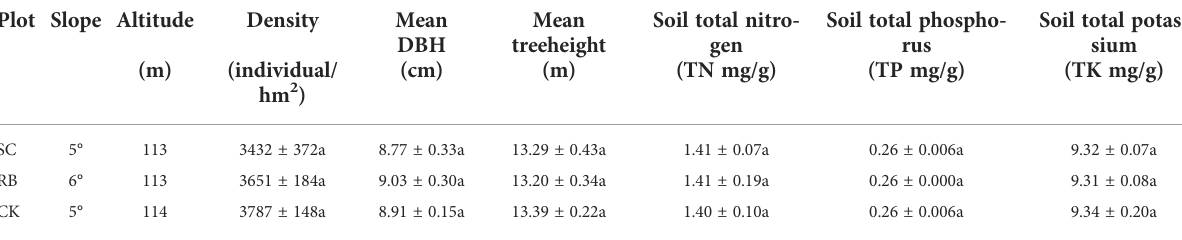
Values represent the mean ± standard deviation (n = 3). Different lowercase letters indicate a signi fi cant difference in stand characteristics between the different treatment plots (p< 0.05).